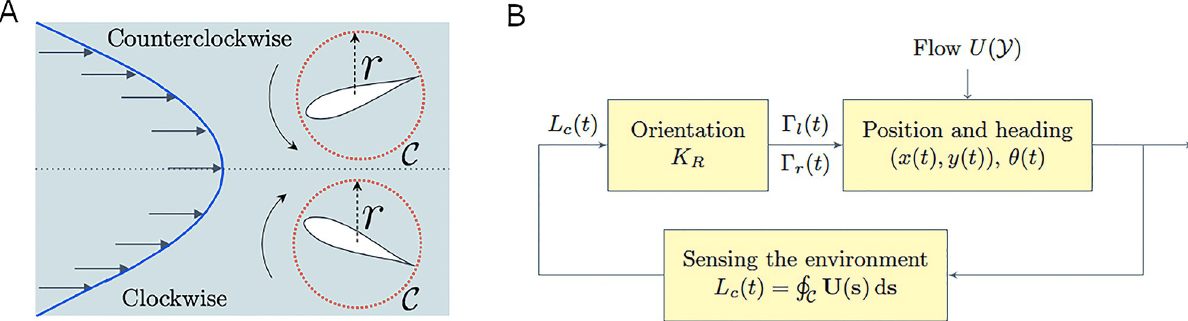
Fig 3. Hydromechanical feedback mechanism. (A) Example of rotation induced by a parabolic flow; the red circle of radius r is the approximation used for the fish perimeter in the computation of the local circulation of the background flow. (B) Block diagram describing the feedback mechanism to orient in the flow and perform